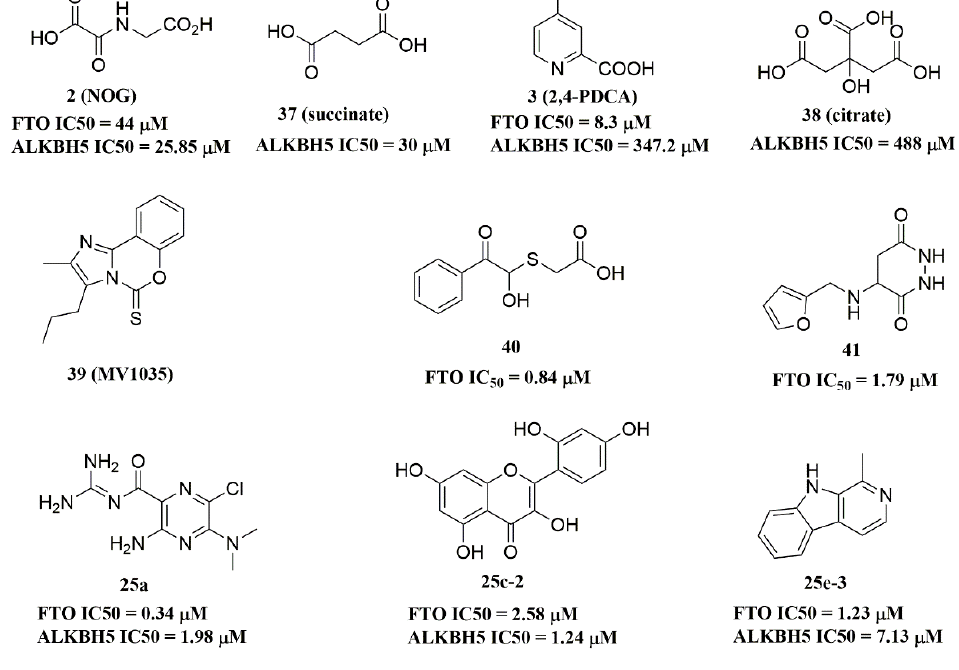
Figure 7. ALKBH5 inhibitors.